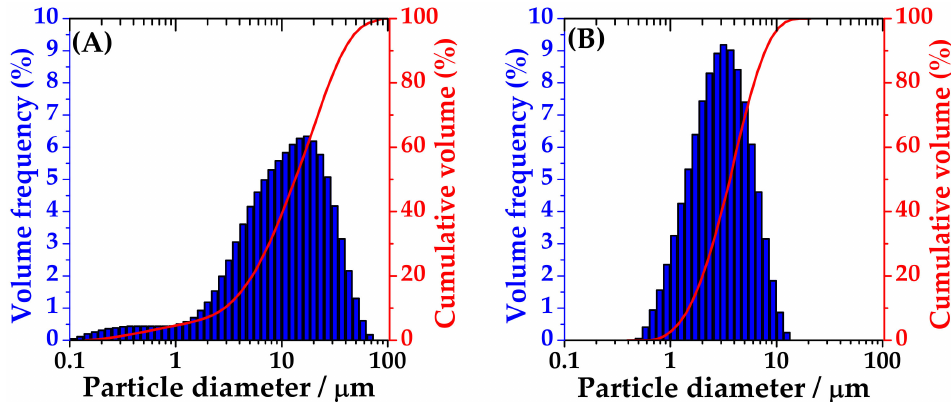
Figure 2. Size distribution of spray-dried particles of HYA–DEX ( A ) and only-DEX ( B ).